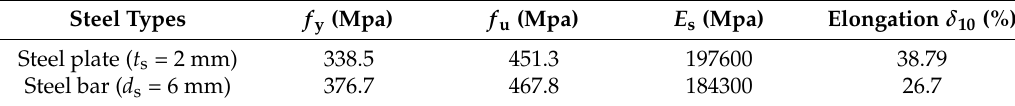
Table 2. Mechanical properties of steel.